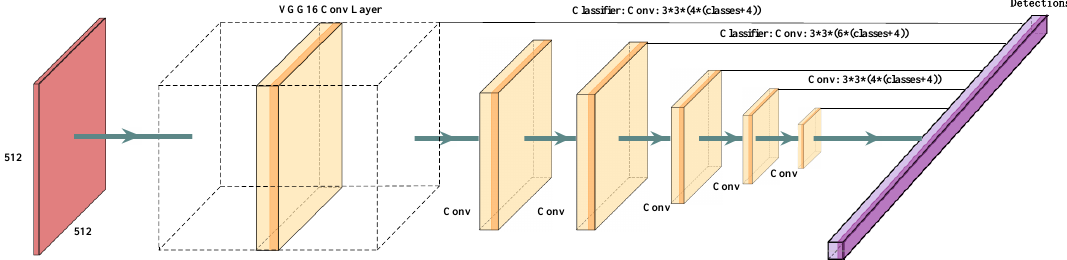
Figure 3. Overview of our detection network. Our model adds several Conv layers to the end of a base network, which predicts the offsets to default boxes of different scales and aspect ratios and their associated